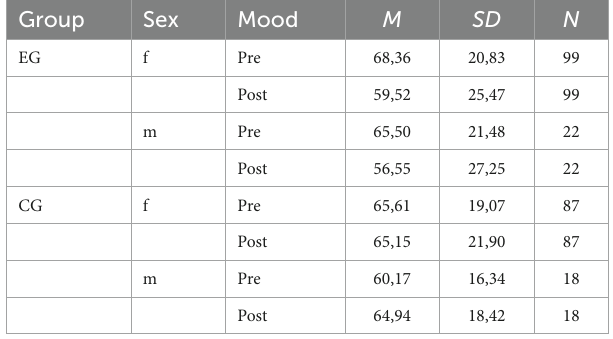
TABLE 2 Mood pre- and post-measurement, divided by group and gender.